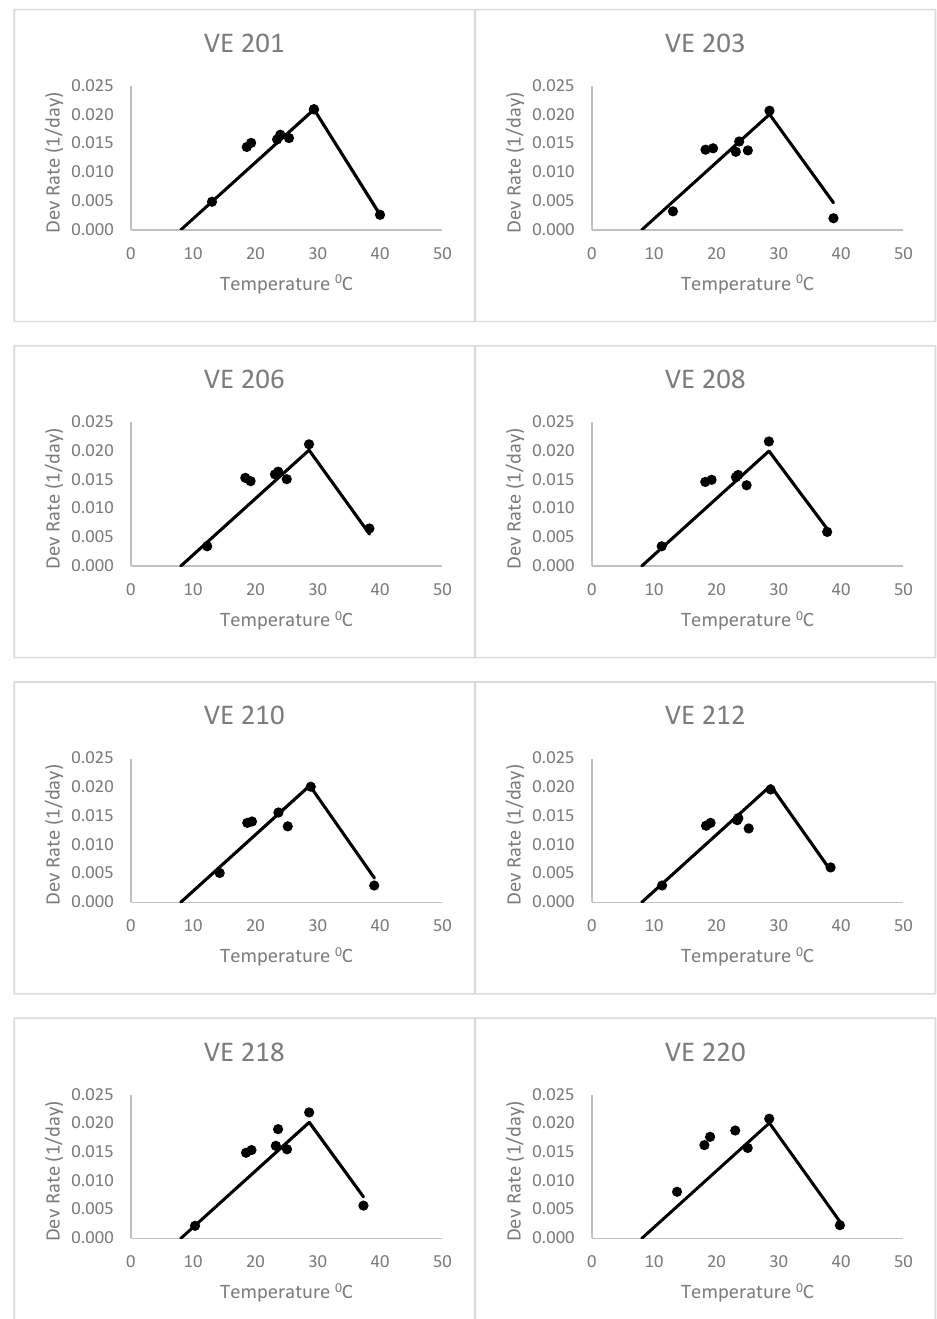
Figure 3. Heat stress regressions (forced through a base temp. of 8 °C) fit to the first variety (VE 201) and then applied to all the varieties.